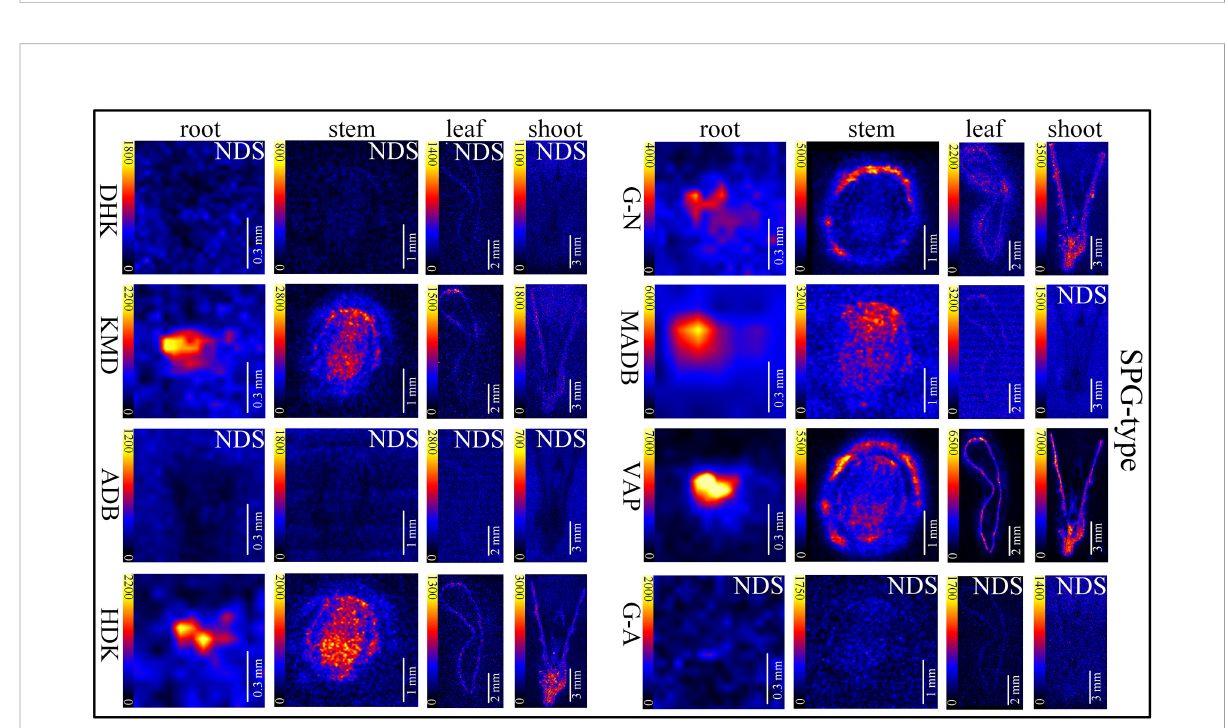
FIGURE 4 In situ visualization of sarpagine-type (SPG-type) alkaloids in different organ/tissue sections. NDS means no detectable signal. The names of the alkaloids are abbreviated. DHK, dehydrokoumidine ( m/z 293.1644); KMD, koumidine ( m/z 295.1810); ADB, 19-( Z )-anhydrovobasinediol ( m/z 309.1881); HDK, 3-hydroxykoumidine ( m/z 311.1760); G-N, gelsemine N-oxide ( m/z 339.1709); MADB, Na-methoxy-19( Z )anhydrovobasinediol ( m/z 339.2071); VAP, 19 E -16- epi -voacarpine ( m/z 369.1814); G-A, gelsempervine A ( m/z